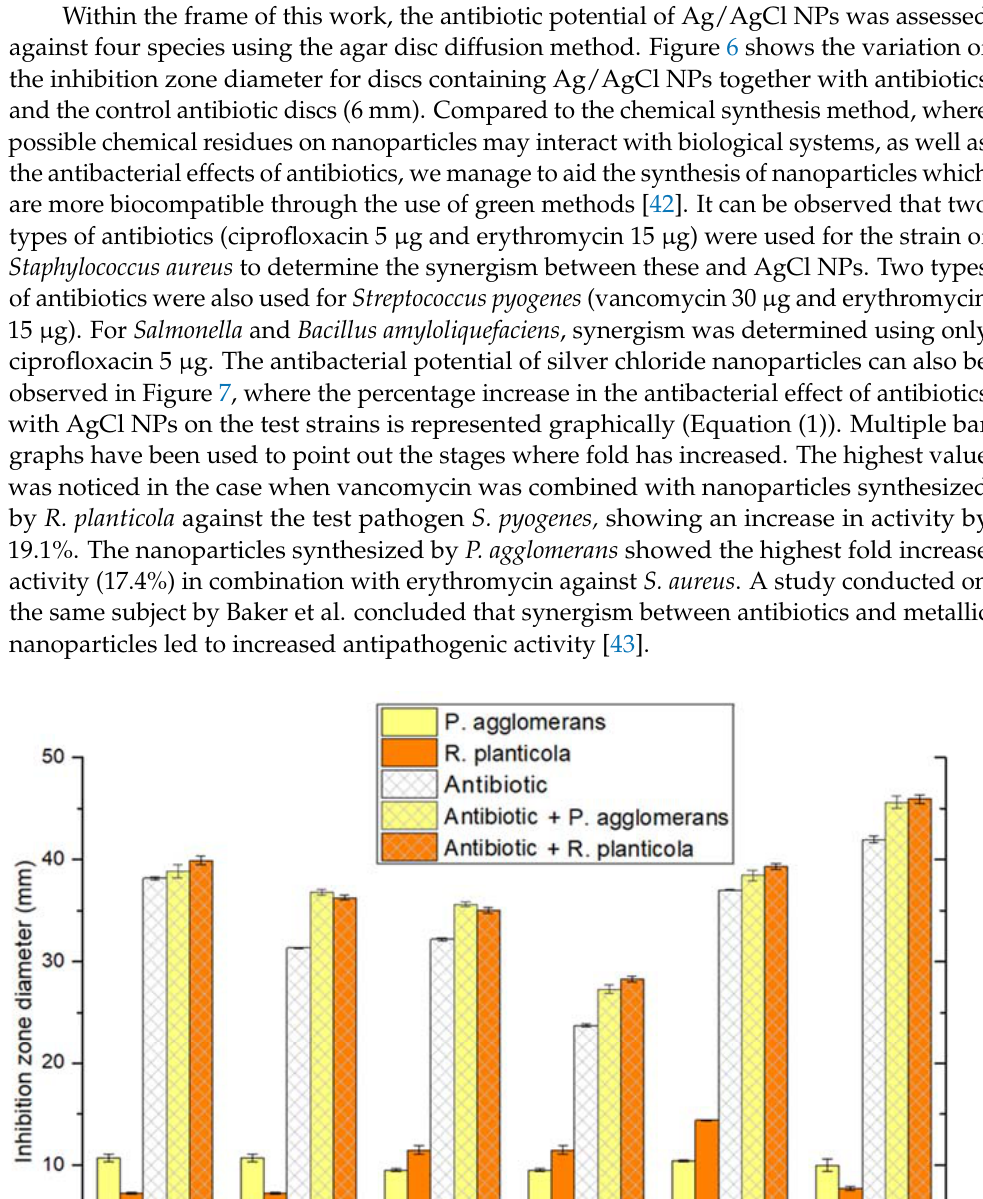
Figure 7. Percentage increase in the antibacterial effect of antibiotics with AgCl NPs against the tested strains . The antimicrobial potential of silver and silver chloride nanoparticles tested through the disc diffusion method is showed photographically in Figure 8. After 24 h incubation, a difference in the inhibition diameter zone can be observed between the control samples (consisting of discs with ciprofloxacin 5 μ g, vancomycin 30 μ g, or erythromycin 15 μ g) and antibiotics in combination with bio ‐ reduced nanoparticles.